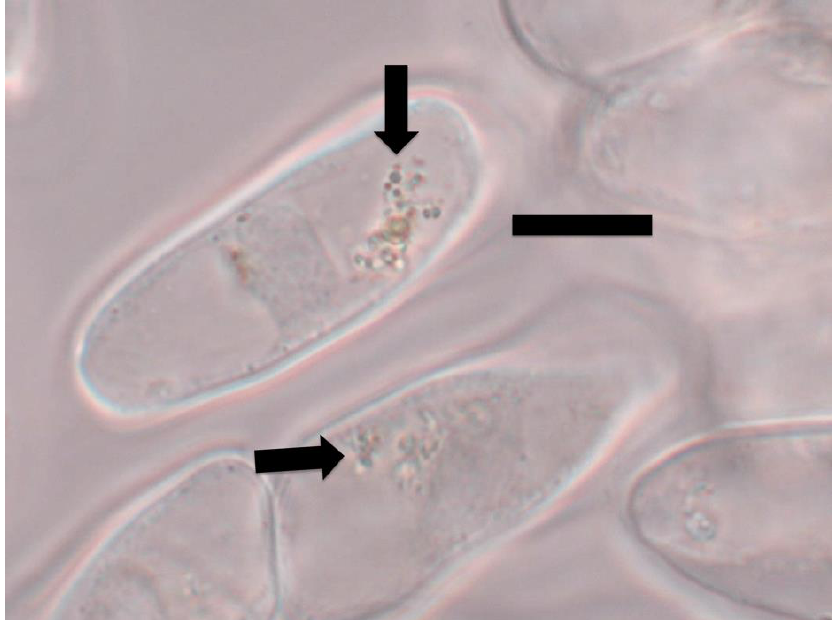
Figure 2. Tomato root cap cells stained with 1% ammonium molybdate to show ethylene (purple color) around bacterial protoplasts (arrow) within root cap cells (bar = 15 µm).